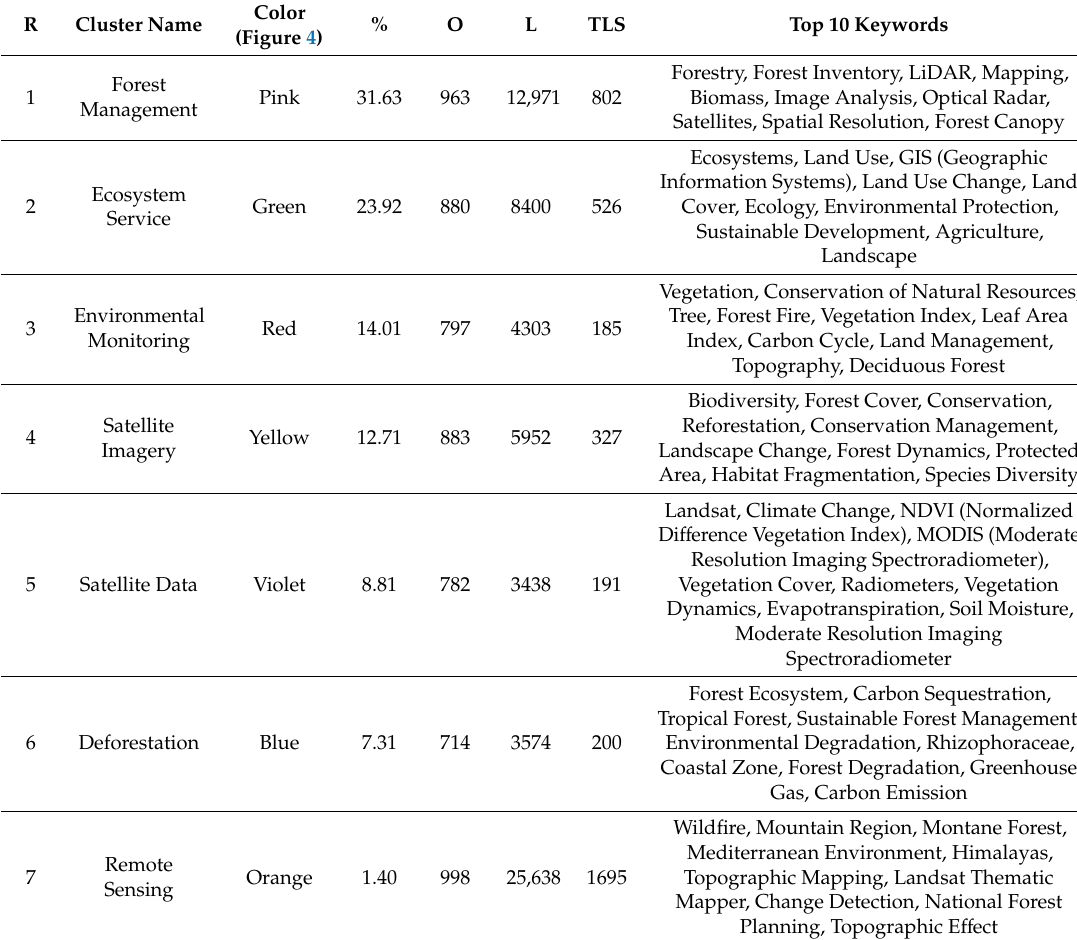
Table 3. Identified clusters of keywords